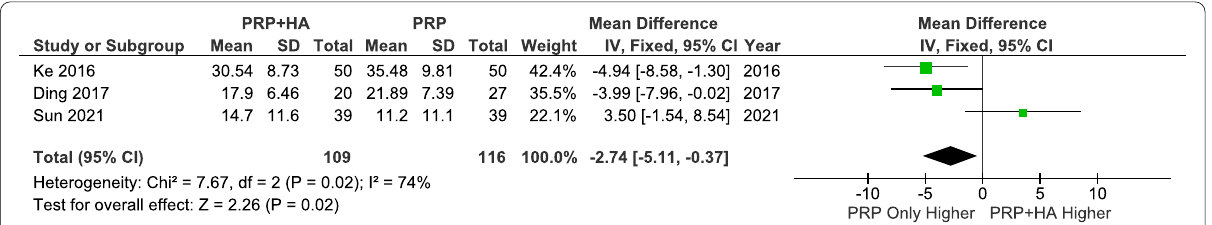
HA and PRP at 3 months after treatment +